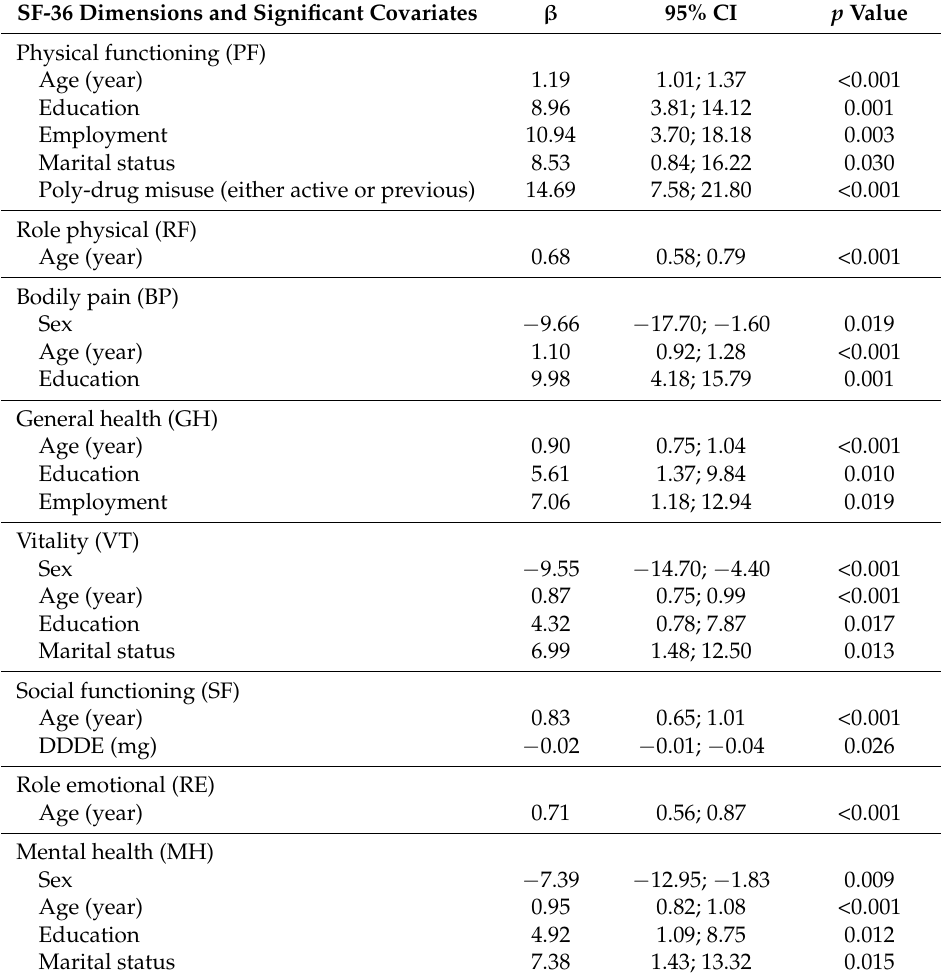
Table 3. Linear regression model analysis for the SF-36